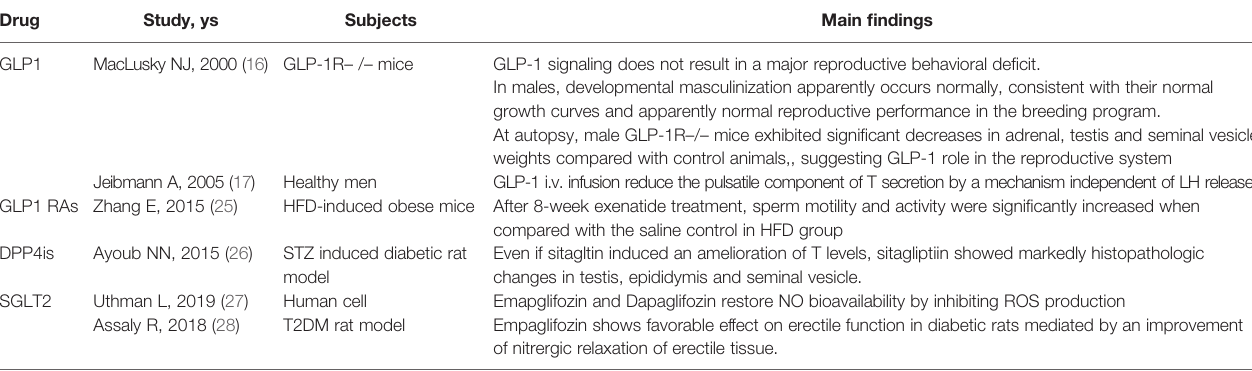
TABLE 1 | Preclinical principal studies results on the effects of